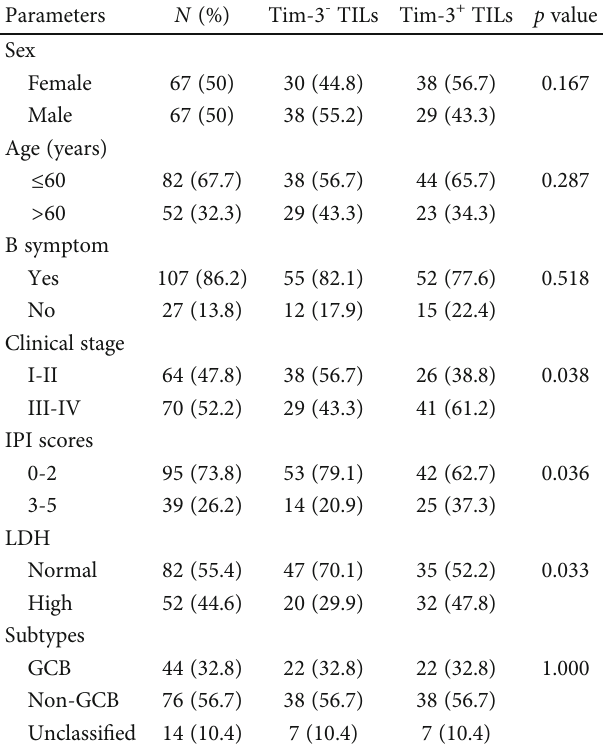
Table 1: Association between Tim-3 expression on TILs and clinicopathologic